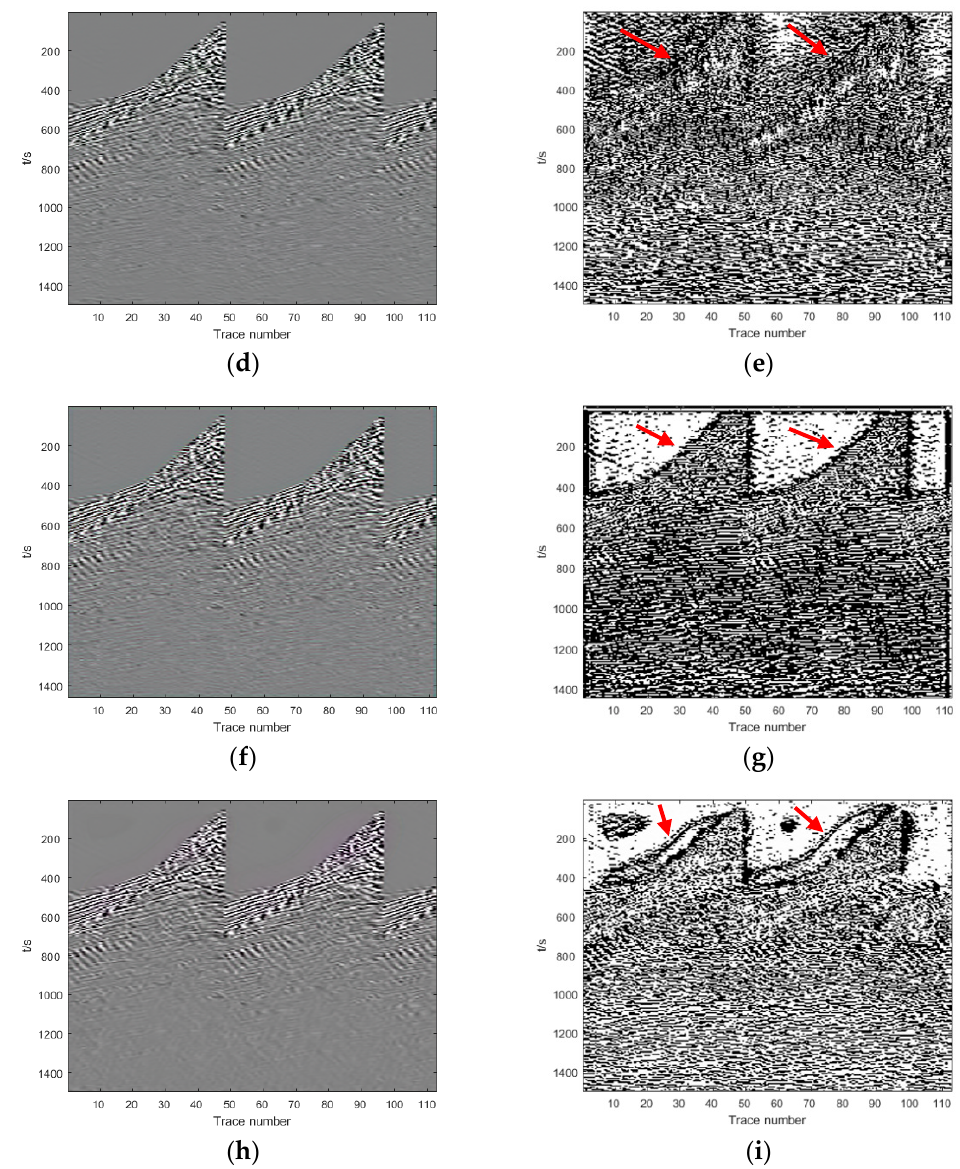
Figure 10. Denoising results of the first field example. The red arrows mark the parts with distinct differences in the difference profiles among each method. ( a ) Noisy data; ( b ) Denoised image through the pre-trained model; ( c ) The difference profiles between noisy data ( a ) and pre-denoised data ( b ); ( d ) Denoised data through the proposed method; ( e ) The difference profiles between noisy data ( a ) and denoised data ( d ); ( f ) Denoised data through the DnCNN; ( g ) The difference profiles between noisy data ( a ) and denoised data ( f ); ( h ) Denoised data through the U-net; ( i ) The difference profiles between noisy data ( a ) and denoised data ( h ).